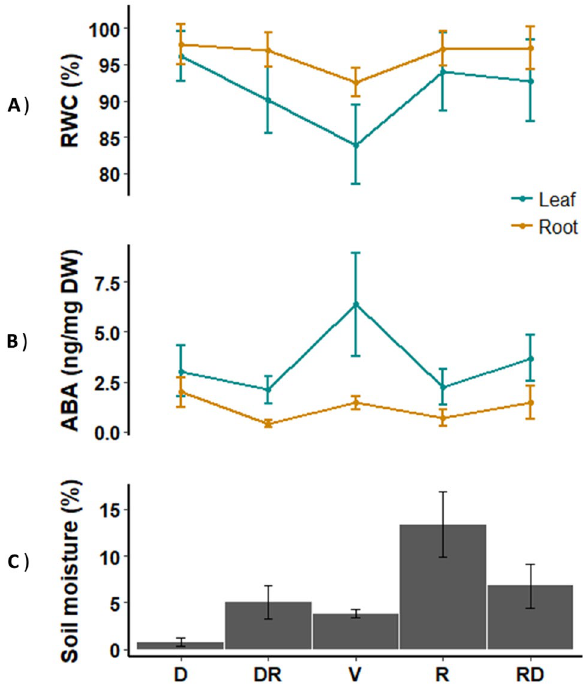
Figure 3. Relative water content (RWC)—( A ) abscisic acid content (ABA)—( B ) and Soil moisture—( C ) in leaves and roots of Gomphrena agrestis Mart. in a rock-field area in the dry and rainy seasons. D dry period, RD transition from dry to rainy period, V veranico period, R rainy period, RD transition from rainy to dry period. Performed using R-software version 3.4.1 66 .